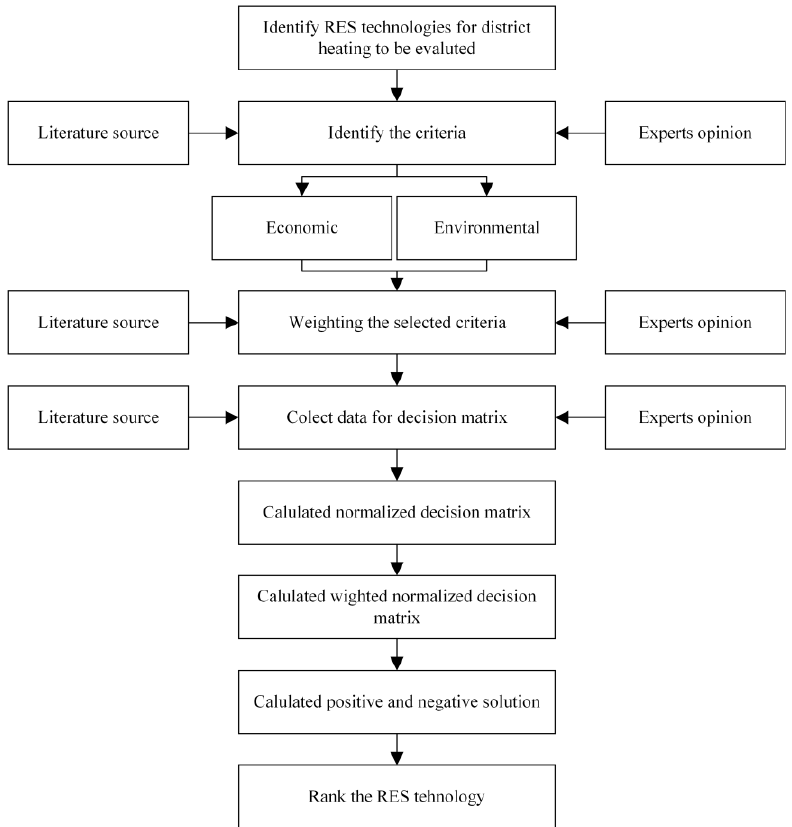
Fig. 1. Decision-making framework.